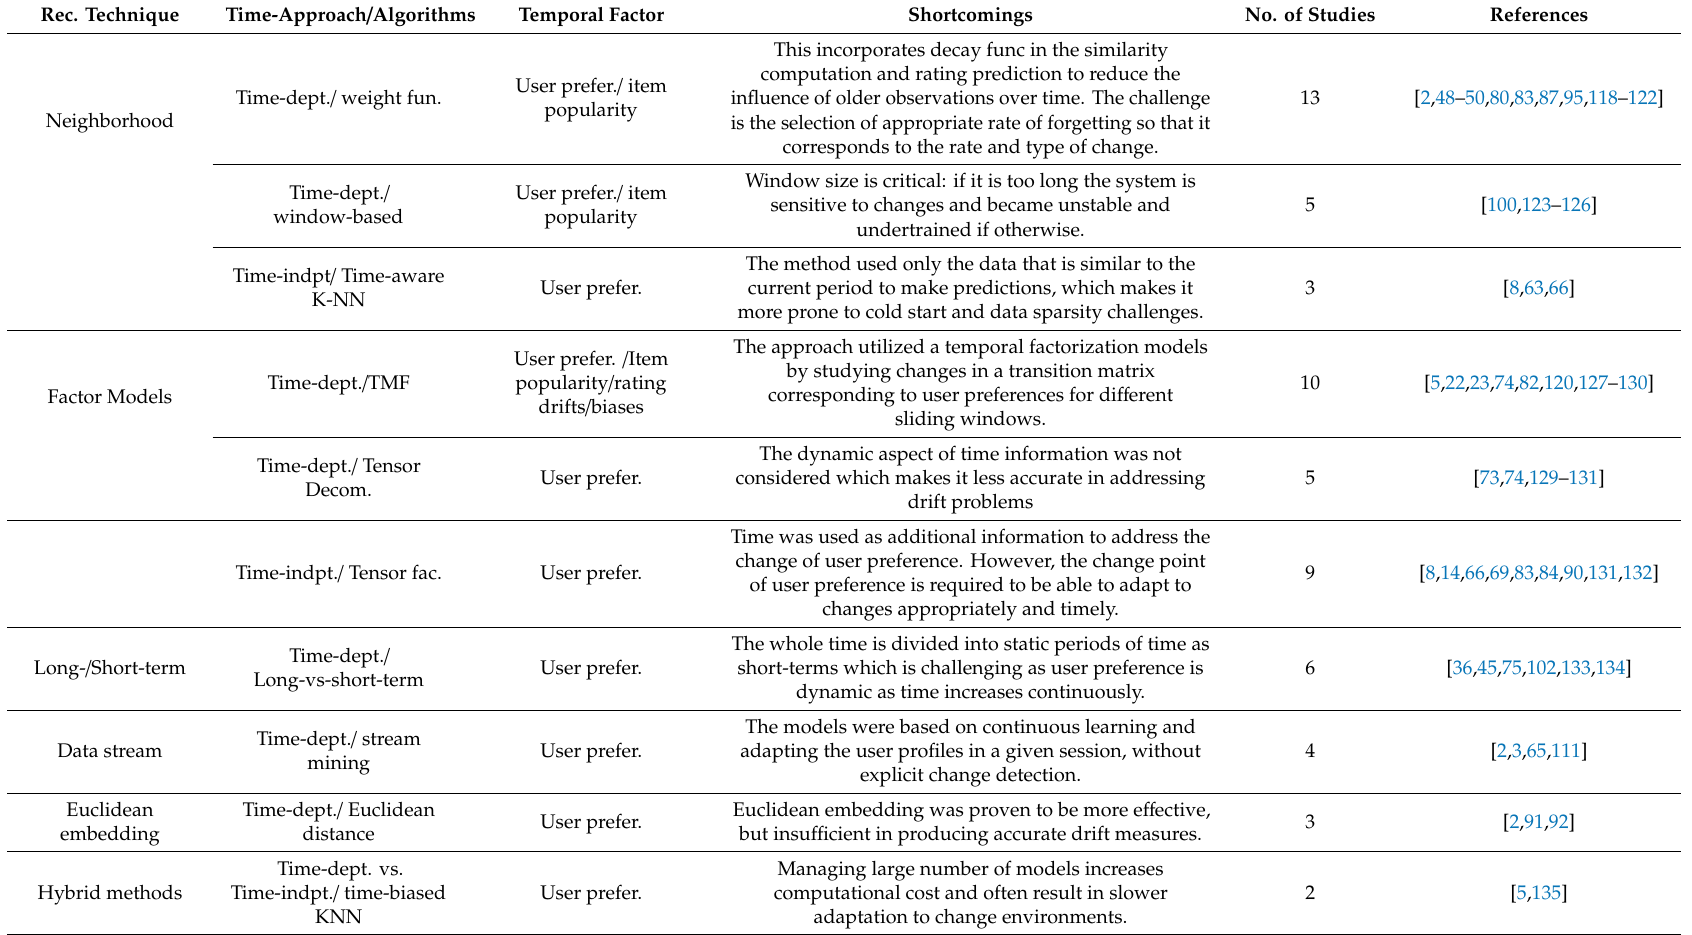
Table 5. Comparison of Temporal CF Algorithms for Recommender